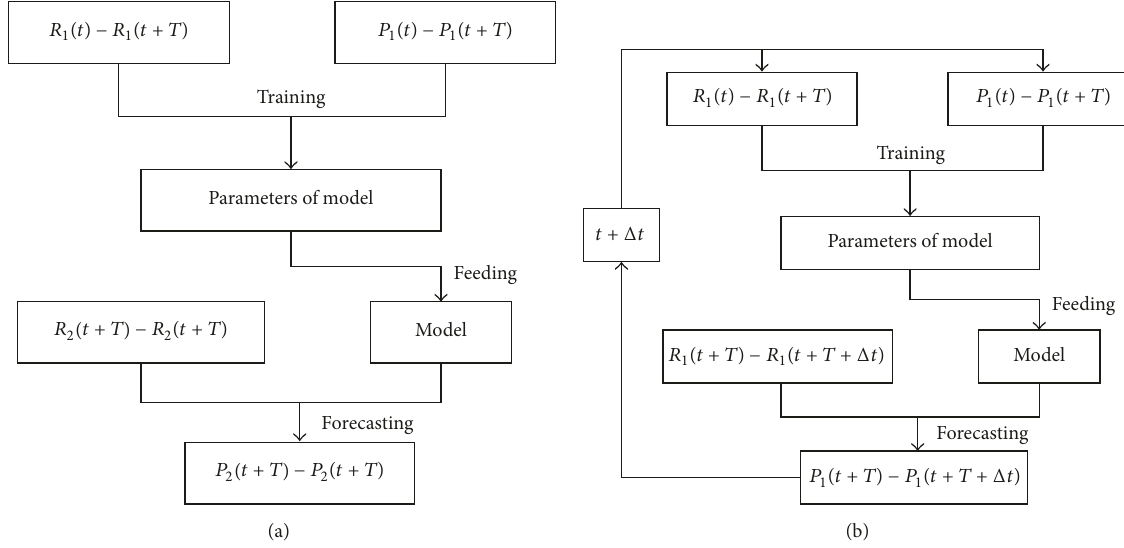
Figure 6: Comparison of calculations of parameters as constants and as variables: (a) nonincremental learning algorithm for parameters as constants and (b) incremental learning algorithm for parameters as